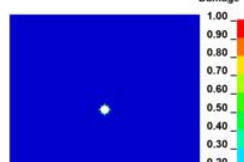
Figure 8. Crack propagation in coal under different blasting methods: ( a ) 15 μ s; ( b ) 100 μ s; ( c ) 200 μ s; ( d ) explosive blasting.